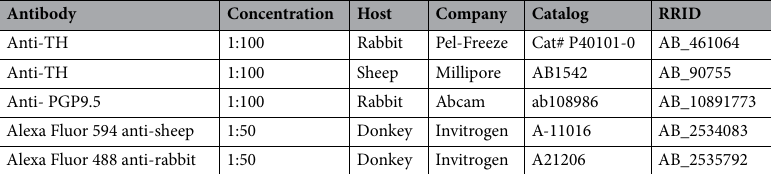
Table 1. Antibodies used in this